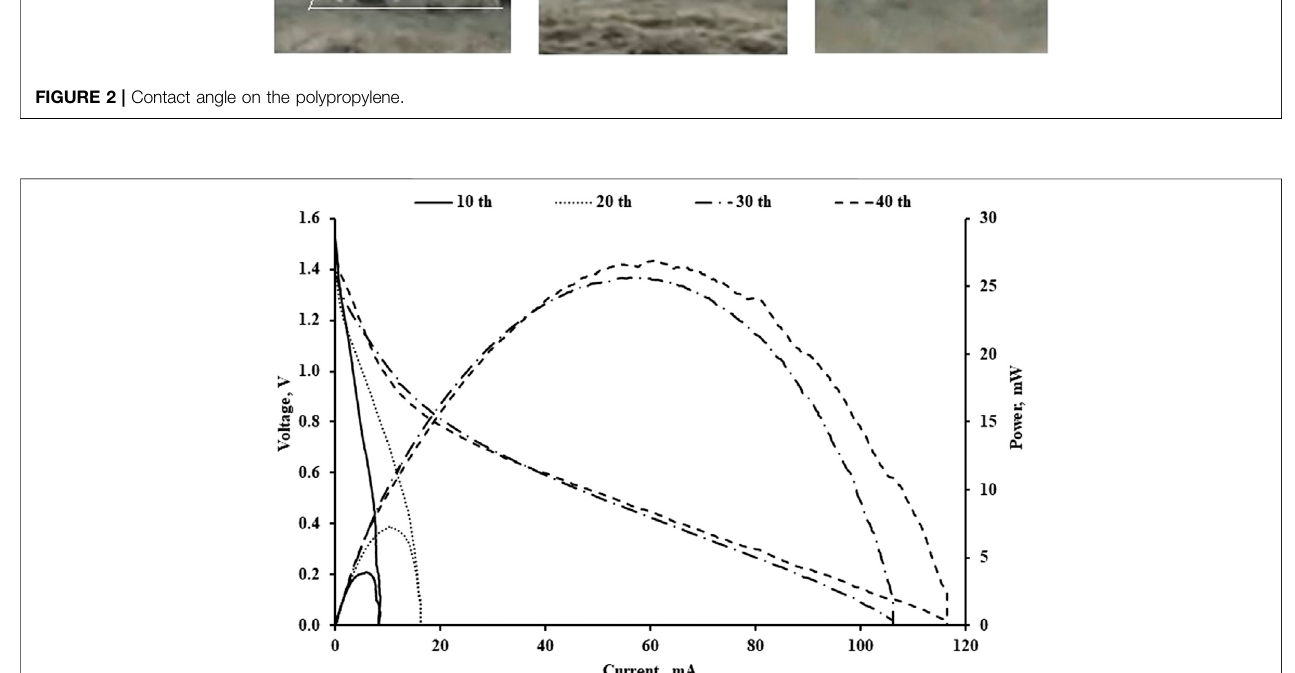
FIGURE 3 | Polarization curve of the activation